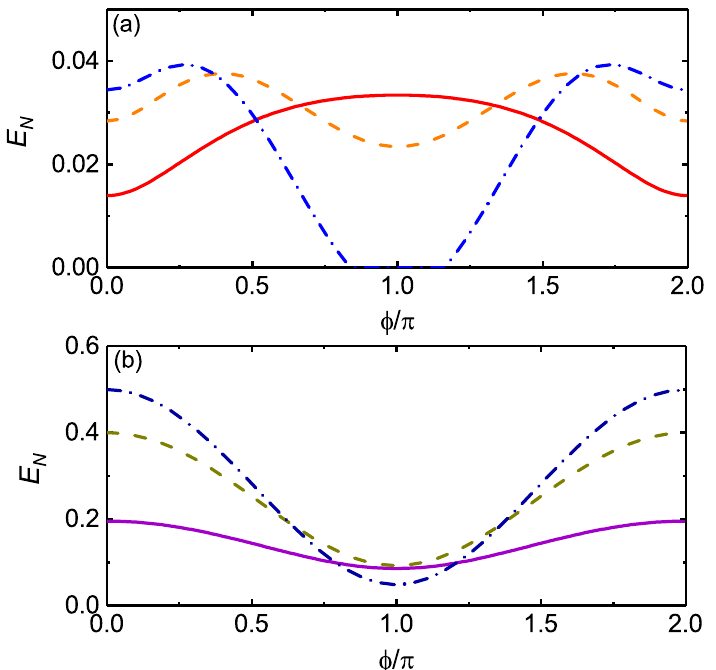
Figure 4. Plots of the logarithmic negativity E N between ( a ) the two cavity modes and ( b ) the two mechanical modes versus the phase difference φ / π for J 12 /2 π = 0.1 MHz (solid lines), 0.2 MHz (dashed lines), and 0.25 MHz (dash-dotted lines). The other parameters are the same as those in Figure